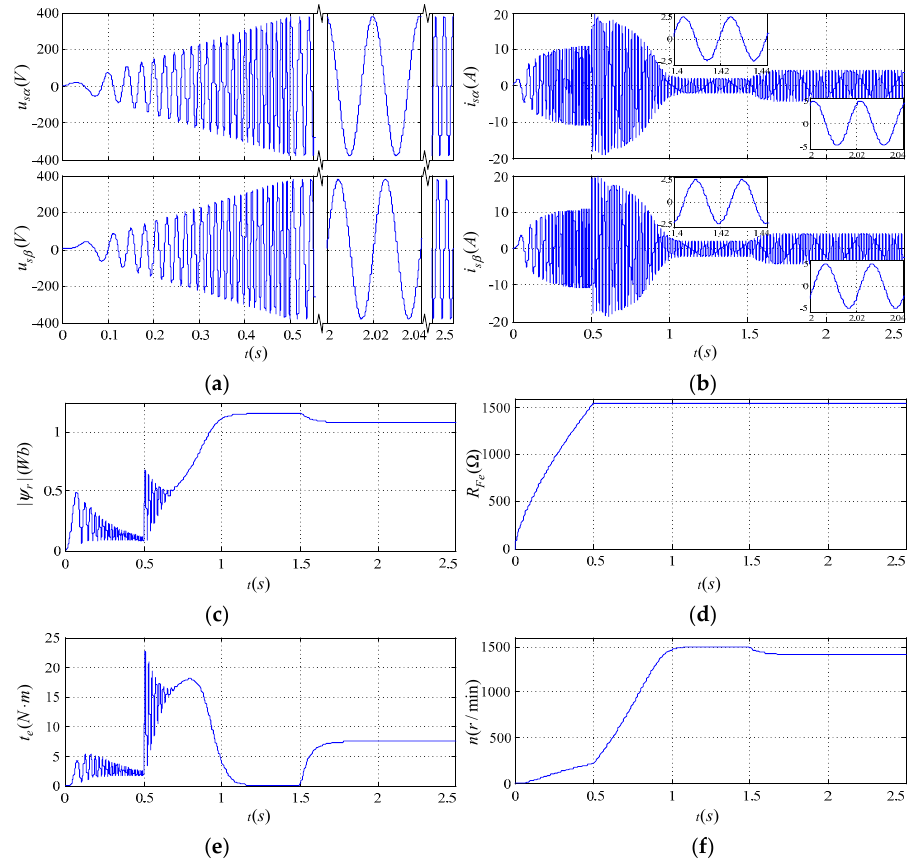
Figure 5. Response of parallel model under given conditions. ( a ) Stator voltage; ( b ) Stator current; ( c ) Magnetic flux amplitude; ( d ) ILS equivalent resistance; ( e ) Electromagnetic torque; ( f )